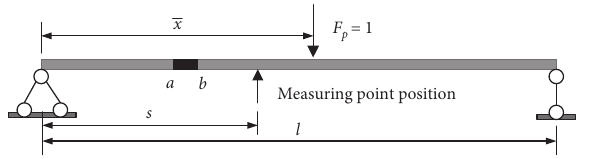
Figure 1: Simply supported beam model.